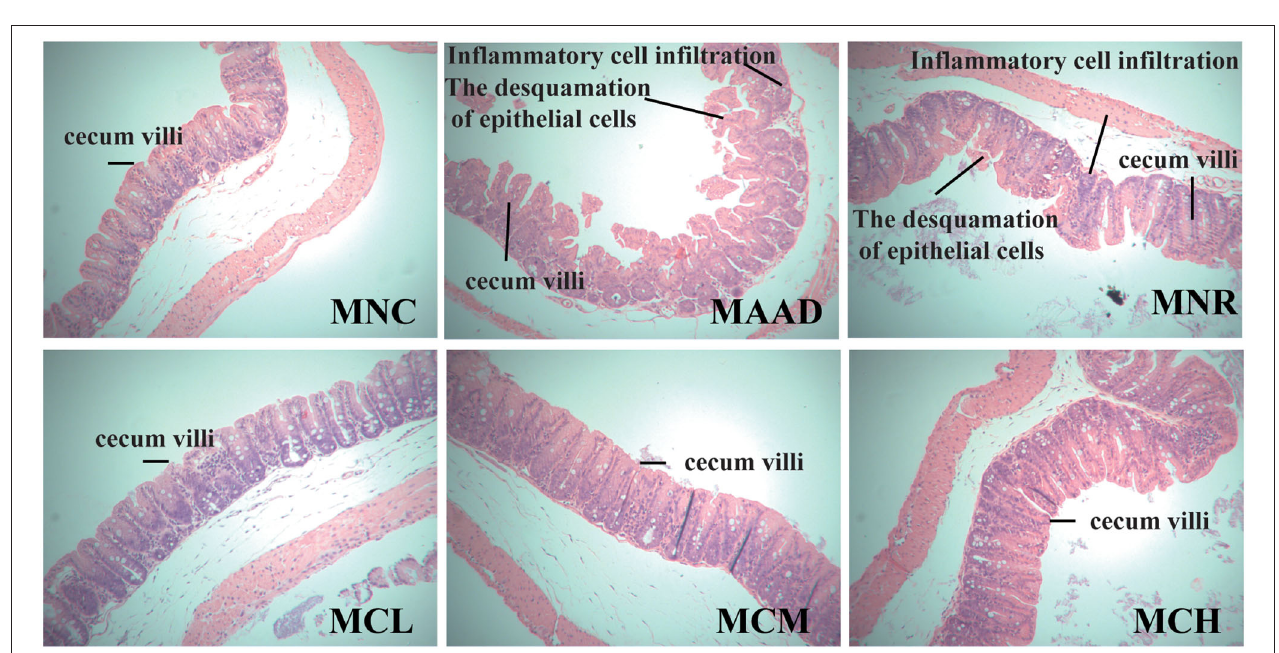
FIGURE 2 | Histological changes of the cecum. Values are shown as means ± SD.